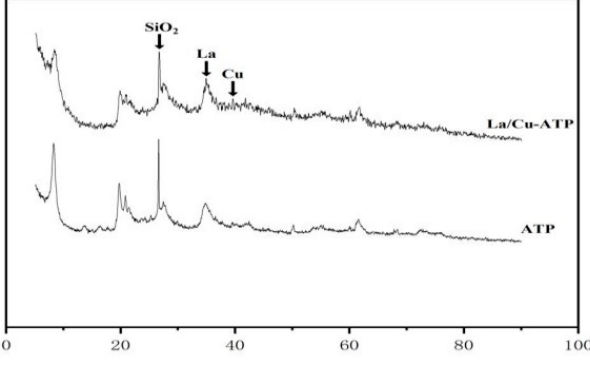
Figure 9. XRD of La 3+ /Cu 2+ -ATP.